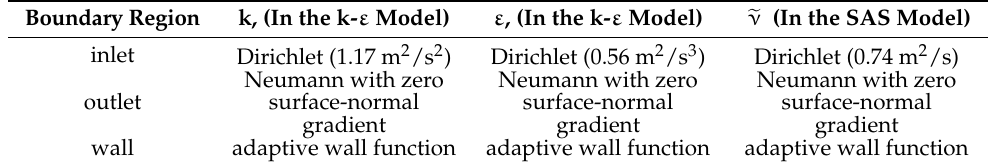
Table 5. Boundary conditions of k, ε and (cid:101) ν . Boundary Region k, (In the k- ε Model) ε , (In the k- ε Model) (cid:101) ν (In the SAS Model) inlet Dirichlet (1.17 m 2 /s 2 ) Dirichlet (0.56 m 2 /s 3 ) Dirichlet (0.74 m 2 /s) Neumann with zero Neumann with zero Neumann with zero outlet surface-normal surface-normal surface-normal gradient gradient gradient wall adaptive wall function adaptive wall function adaptive wall